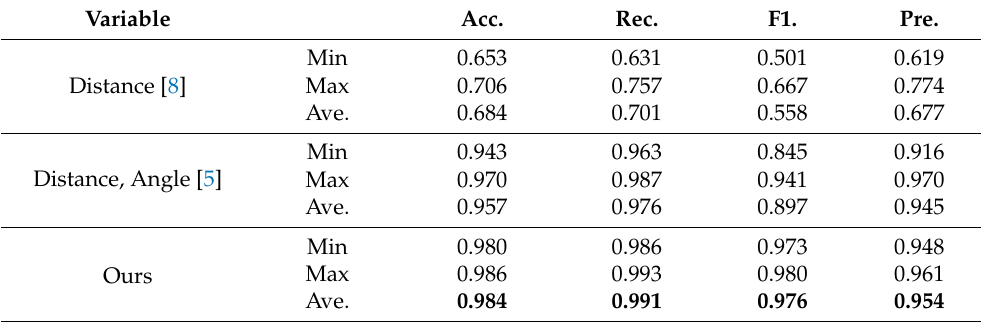
Table 4. Comparison results of input parameters for pedestrian interference recognition. Recognition Accuracy (Acc.), Recall (Rec.), F1-score (F1.), Precision (Pre.). Min, Max, and Average (Ave.) results.